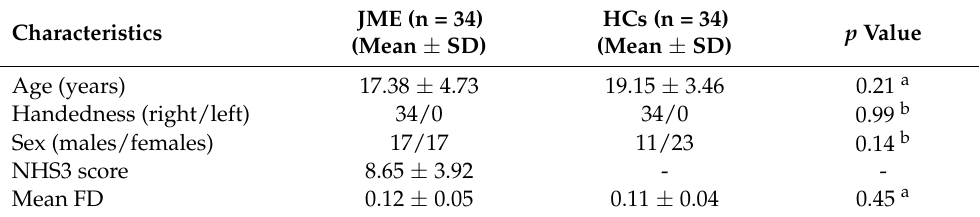
Table 1. Demographic and neuropsychological characteristics of the participants. Characteristics